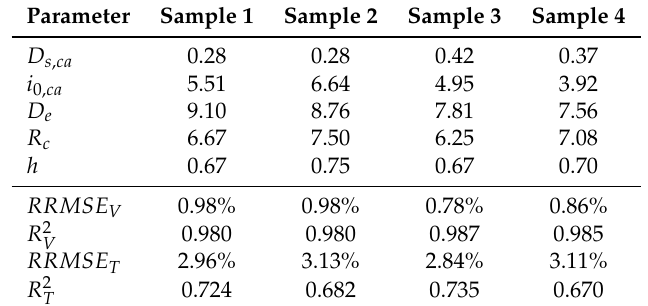
Table 8. Optimal values of the multipliers and dimensionless decision variables for cell cycling calibrations.